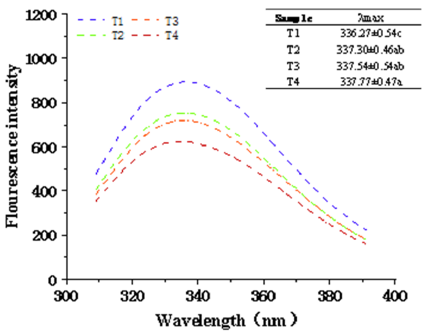
Figure 6. Effects of ultrasound-assisted sodium bicarbonate treatment on the fluorescence emission spectra of raw pork myofibrillar protein. T1, sodium bicarbonate 0 g, ultrasound time 0 min; T2, sodium bicarbonate 0.2 g, ultrasound time 0 min; T3, sodium bicarbonate 0.2 g, ultrasound time 30 min; T4, sodium bicarbonate 0.2 g, ultrasound time 60 min Each value represents the mean ± SE, n = 4. a–c Different parameter superscripts indicate significant differences ( p <